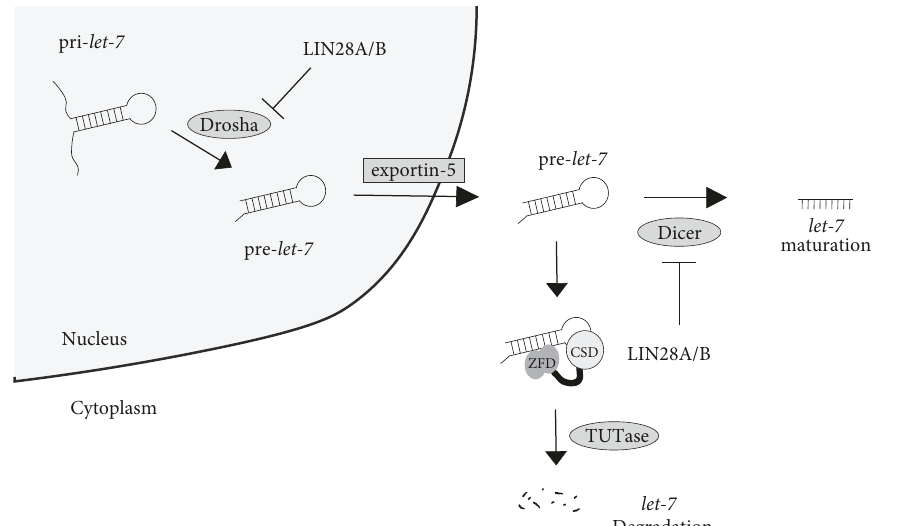
Figure 1: A schematic diagram of the let-7 biogenesis . Pri- let-7 microRNA precursors are processed in the nucleus by Drosha to pre- let-7 . Pre- let-7 microRNA precursors are exported to the cytoplasm by exportin-5, where they are subsequently processed by Dicer resulting in the mature let-7 . RNA binding protein LIN28A or LIN28B binds to either pri- let-7 or pre- let-7 using RNA binding domains, cold shock domain (CSD), and two zinc finger domains (ZFDs) and blocks the processing. Upon binding to pre- let-7 , LIN28A or LIN28B recruits TUTase, which causes oligouridylation resulting in the degradation of pre- let-7